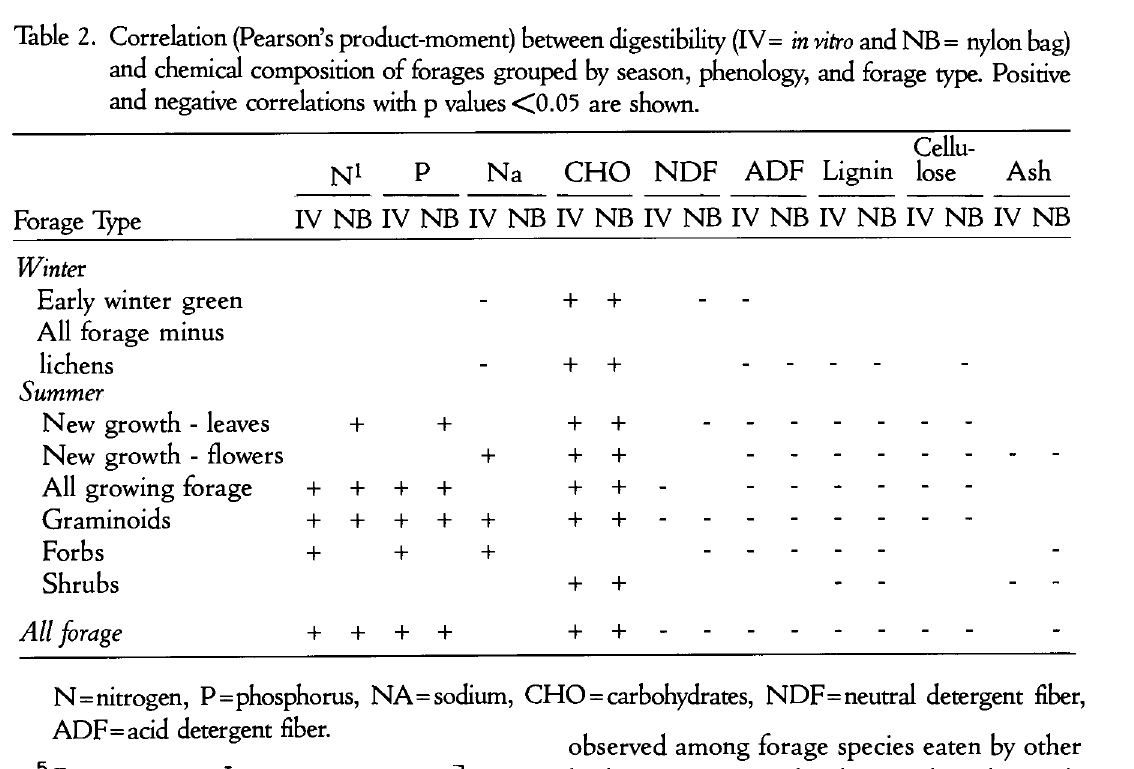
N = nitrogen, P = phosphorus, NA = sodium, CHO = carbohydrates, NDF=neutral detergent fiber, ADF = acid detergent